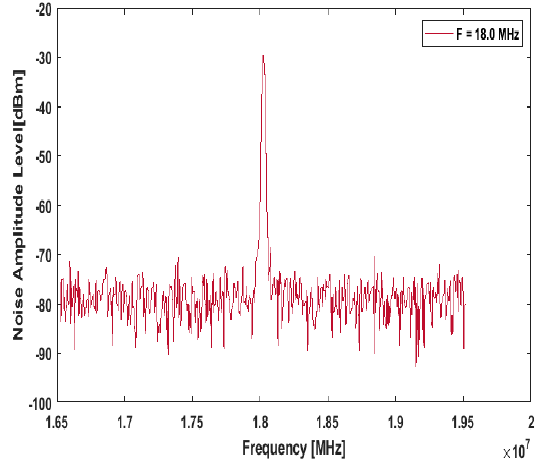
Figure 14. Waveform at 18 MHz.